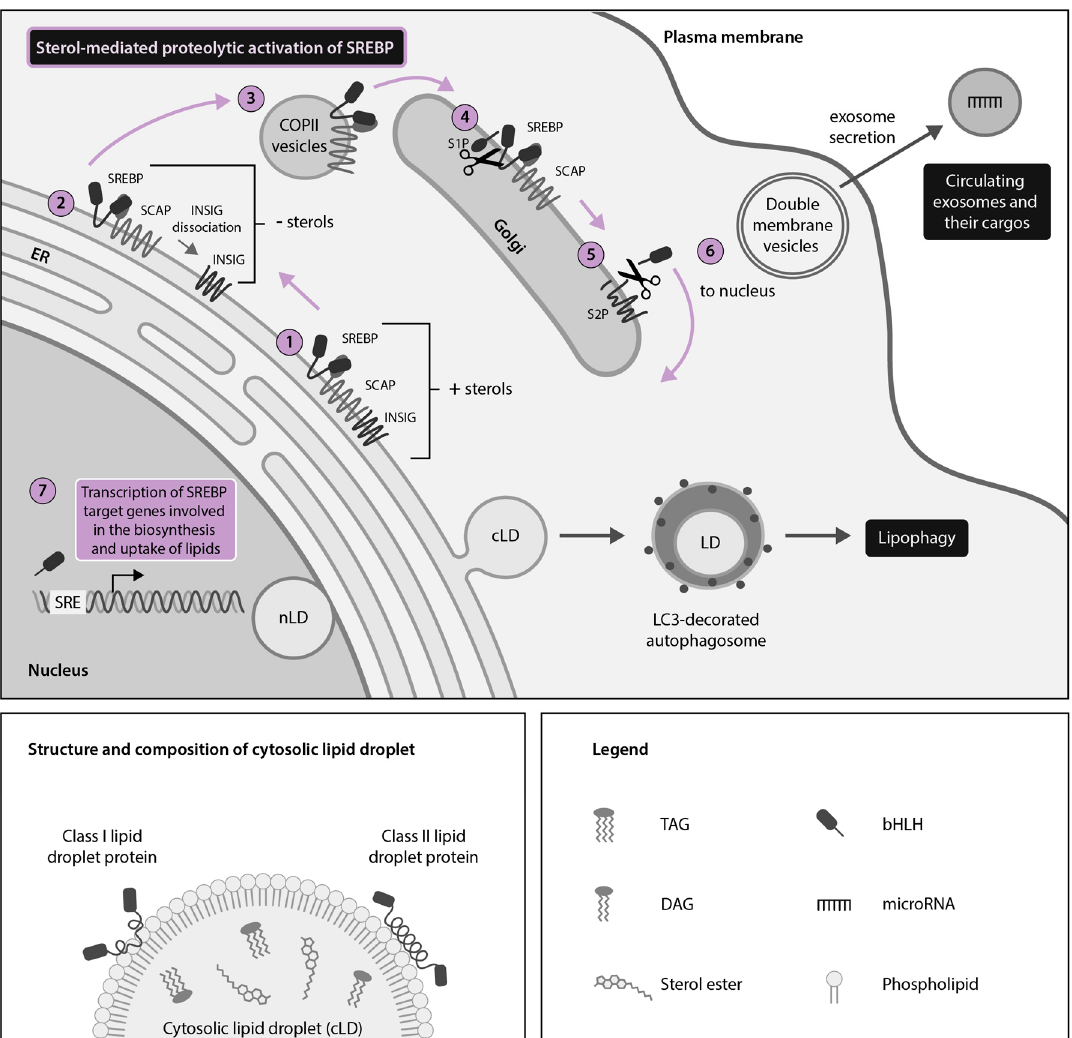
Figure 1. The sterol regulatory element-binding protein (SREBP) pathway is a master regulator of cellular lipid droplet (LD) metabolism. LDs are spherical organelles composed of a phospholipid monolayer surrounding a core of neutral lipids. LDs have been described in both the cytoplasm (cLDs) and nucleus (nLDs) of homeostatic cells, with cLDs being better described. cLDs serve as docking platforms for Class I and Class II host LD proteins. LD metabolism is controlled by endoplasmic reticulum (ER)- and nuclear membrane-bound proteins called SREBPs, which control expression of key target genes involved in the biosynthesis and uptake of cholesterol and other lipids. When sterol levels are high, SREBPs are retained in an inactive state in the ER by SREBP-cleavage activating protein (SCAP) and insulin-induced gene (INSIG) ( 1 ). When sterol levels are low, INSIG dissociates from SCAP at the ER ( 2 ) and coat protein II (COPII)-coated vesicles transport SREBP-SCAP complexes to the Golgi apparatus ( 3 ), where the active N-terminal portion of SREBPs is cleaved by site-1 protease (S1P) ( 4 ) and site-2 protease (S2P) ( 5 ). The N-terminal portion of SREBPs then translocates to the nucleus ( 6 ) to act as a transcription factor coordinating expression of many lipid-metabolism related genes ( 7 ) that can subsequently impact LD biogenesis. SREBP regulation of LD metabolism can be further fine-tuned by exosome-packaged host microRNAs (miR) such as miR-29 (inhibits SCAP and SREBP-1 expression), miR-33 (inhibits SREBP-1 expression) and miR-24 (inhibits INSIG expression). SREBP-regulated LD homeostasis also intersects with other cellular pathways such as lipophagy, which catabolizes LDs in microtubule-associated protein light chain 3 (LC3)-decorated autophagosomes to liberate their component lipids.